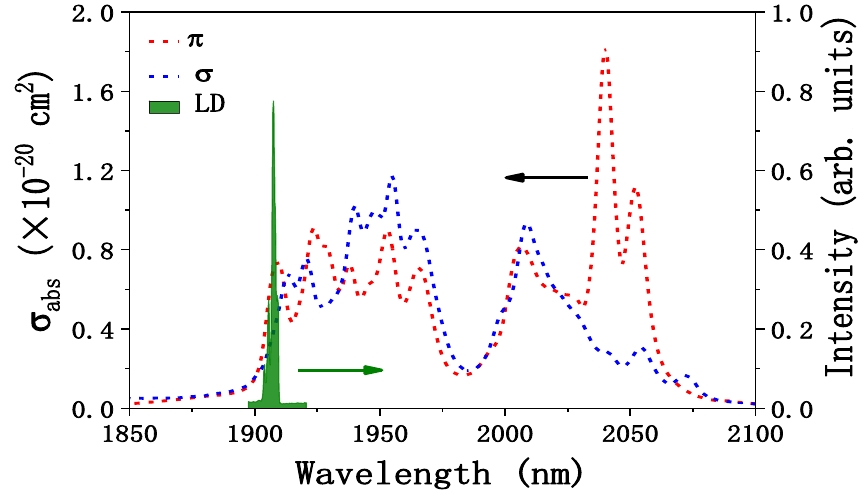
Figure 1. Absorption cross sections of the Ho:YVO 4 crystal and the radiation spectrum of the LD.